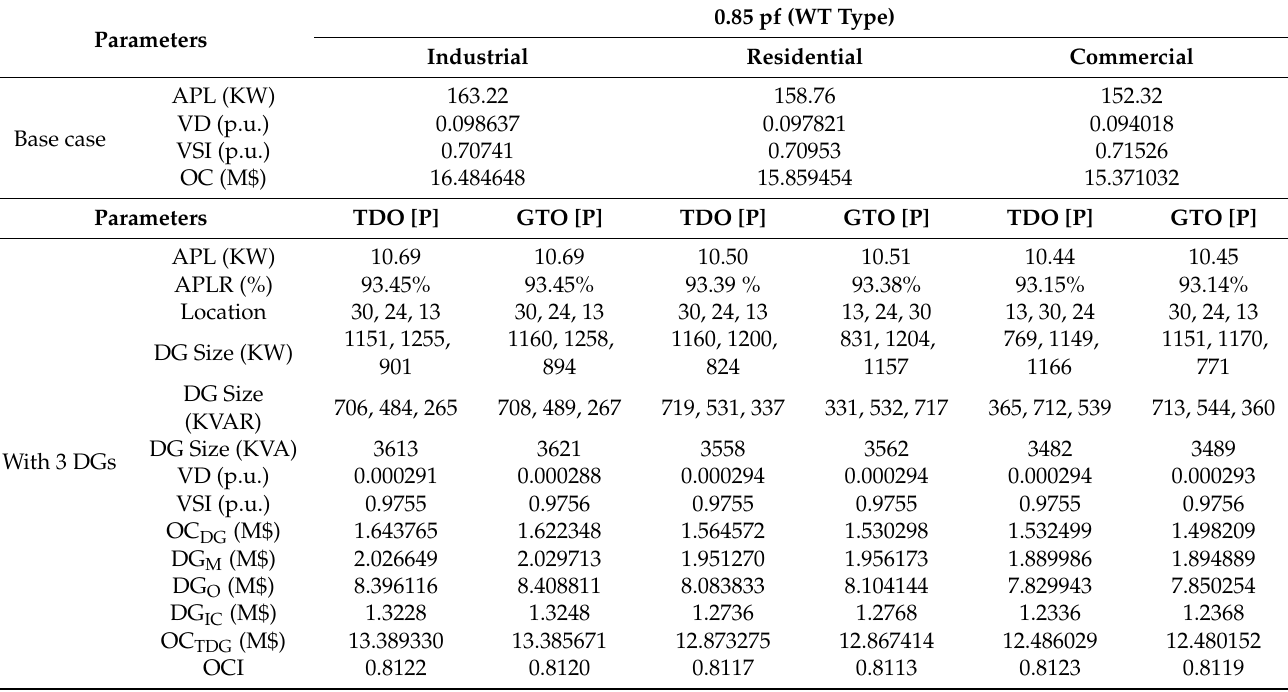
Table 10. Results of OADG for a 33-bus RDN for MOF at 0.85 pf (WT type) with a VP load